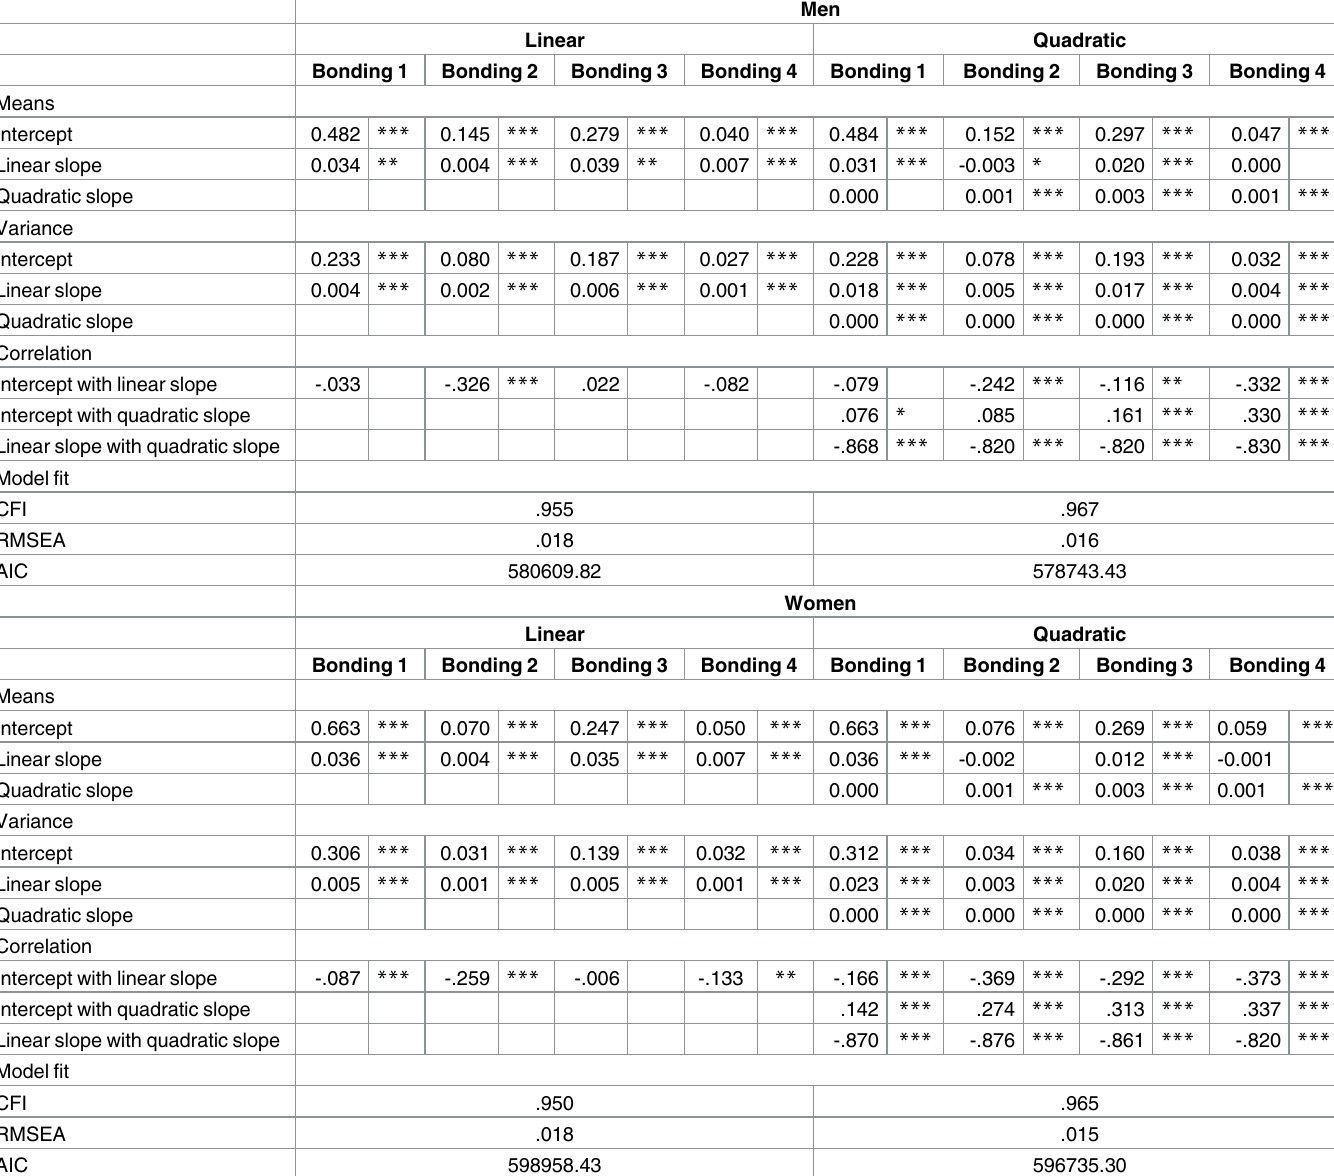
Table 4. Estimated values of the linear growth model (linear) and the quadratic growth model (quadratic) for social capital by